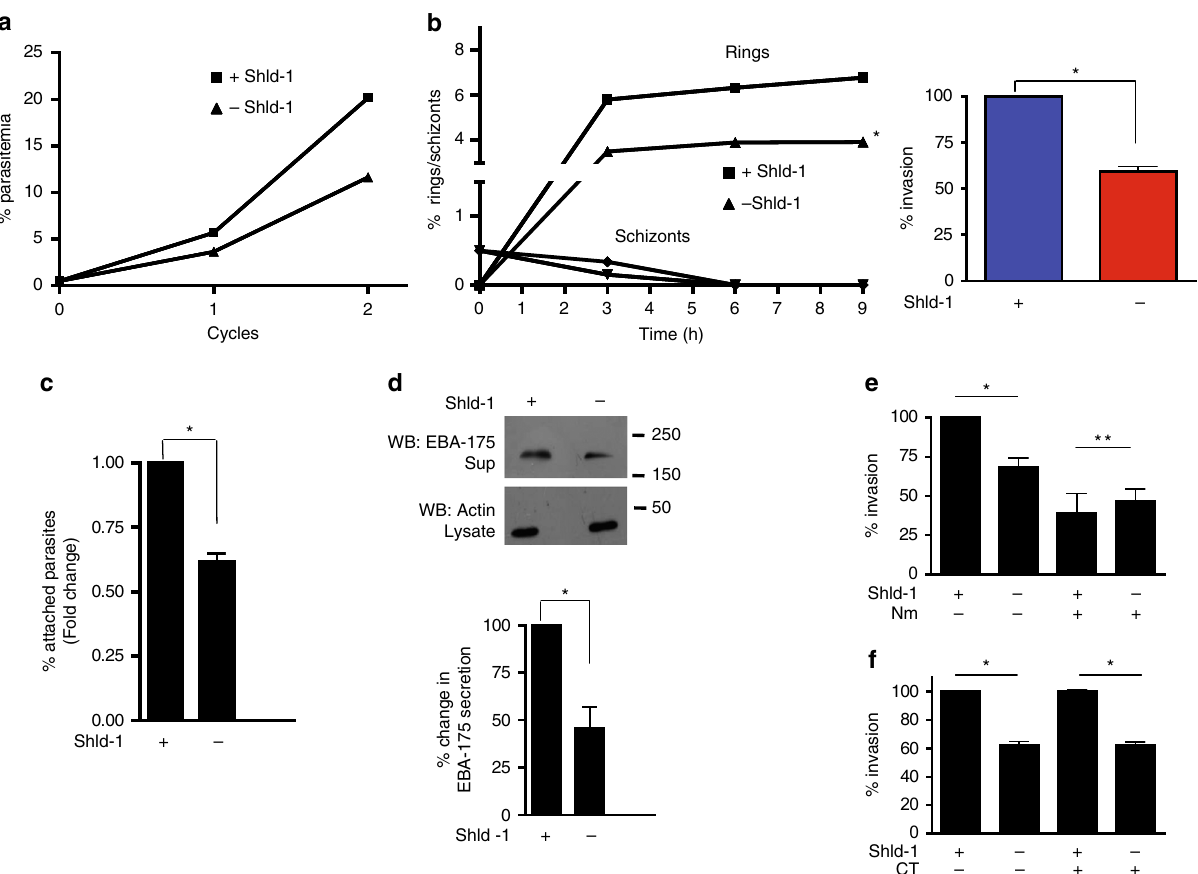
Fig. 5 PfCDPK1 regulates invasion of host erythrocytes by P. falciparum . a Depletion of PfCDPK1 results in reduced growth of PfCDPK1-3HA-DD parasites. Synchronized PfCDPK1-3HA-DD parasites were cultured either in the presence or absence of Shld-1. % parasitemia was determined by counting at least 500 erythrocytes from Giemsa-stained thin blood smears which were prepared after every cycle, which indicated that parasites were mostly in ring forms. b PfCDPK1 may play a role in host cell invasion by P. falciparum . Schizonts ± Shld-1 were incubated with fresh erythrocytes and after indicated time blood smears were prepared and the number of schizonts and rings were counted and represented as % infected erythrocytes. Shld-1 removal lead to a signi fi cant decrease in the number of rings, which were counted from thin blood smears (Mean ± s.e.m., *, t -test, n = 4, P < 0.05). Right Panel , % invasion was